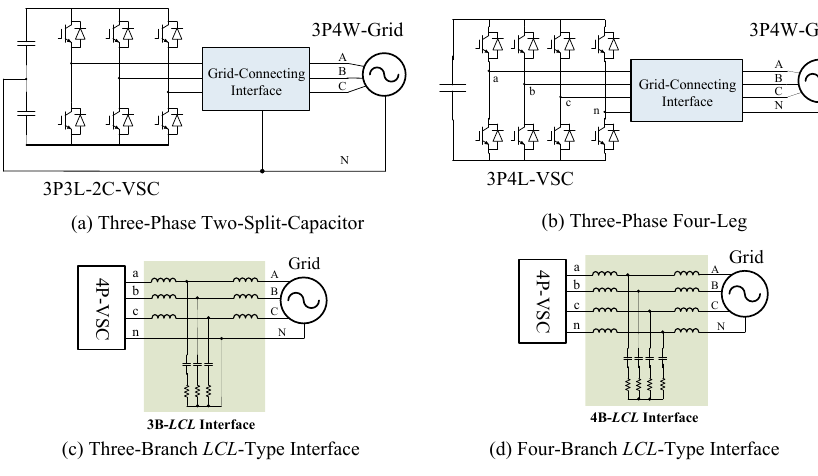
Figure 1. Three-phase, four-wire active power filter and its grid-connecting